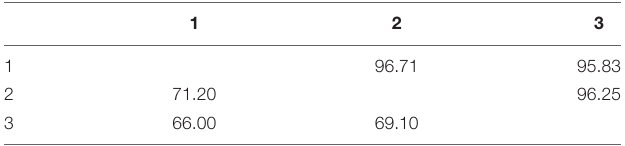
TABLE 2 | Pairwise ANI (Yoon et al., 2017b) and dDDH (Meier-Kolthoff et al., 2013) values between the type/representative strains of three subclades of the